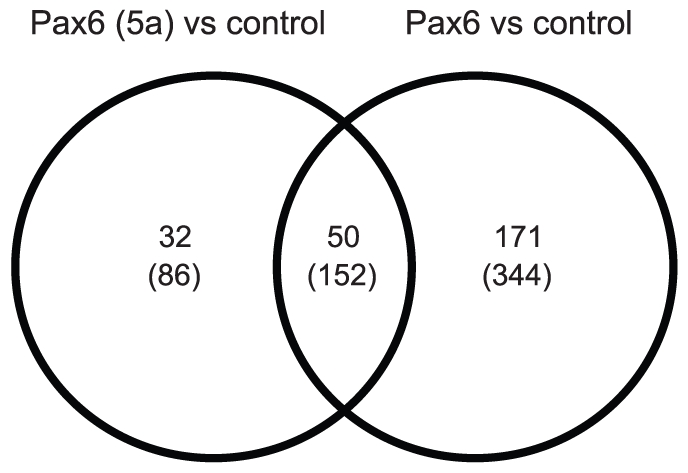
Venn diagram shows the number of individual and common sets of genes regulated by Pax6 and Pax6(5a) in a gene expression microarray.Three RNA samples from the FlpIn-3T3 control cell line, three samples from the FlpIn-3T3 Pax6(5a) cell line and two samples from the FlpIn-3T3 Pax6 cell line were sent for microarray analysis on the Illumina Mouse Ref-8 V1.1 chip. The number of genes differentially regulated as scored by threshold 1 is shown, while use of threshold 2 gave numbers shown in parentheses. (Threshold 1 is FDR p-value 0.001, FC 1.7, log FC 0.77. Threshold 2 is FDR p-value 0.01, FC 1.5, log FC 0.58).